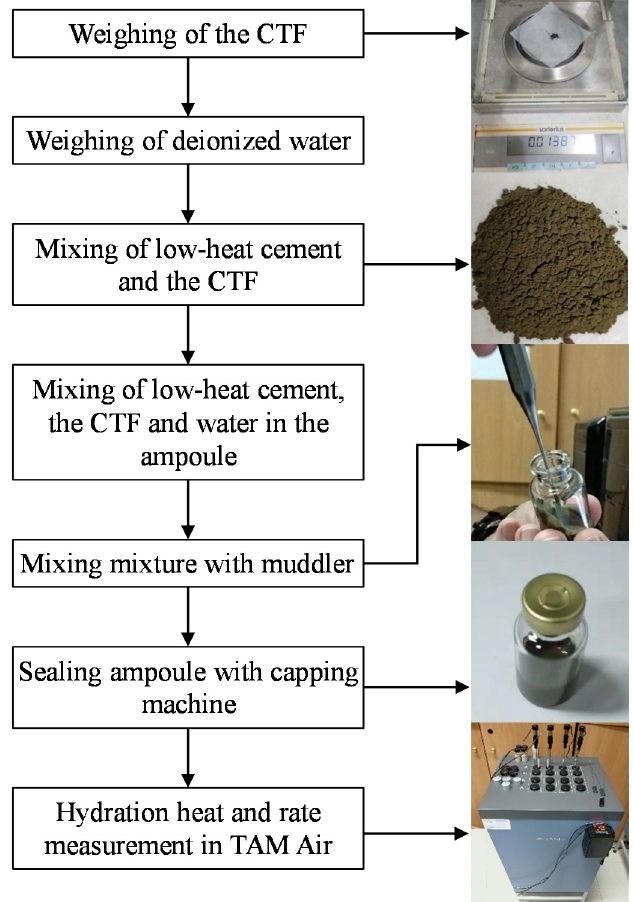
Figure 5. The hydration test flow.